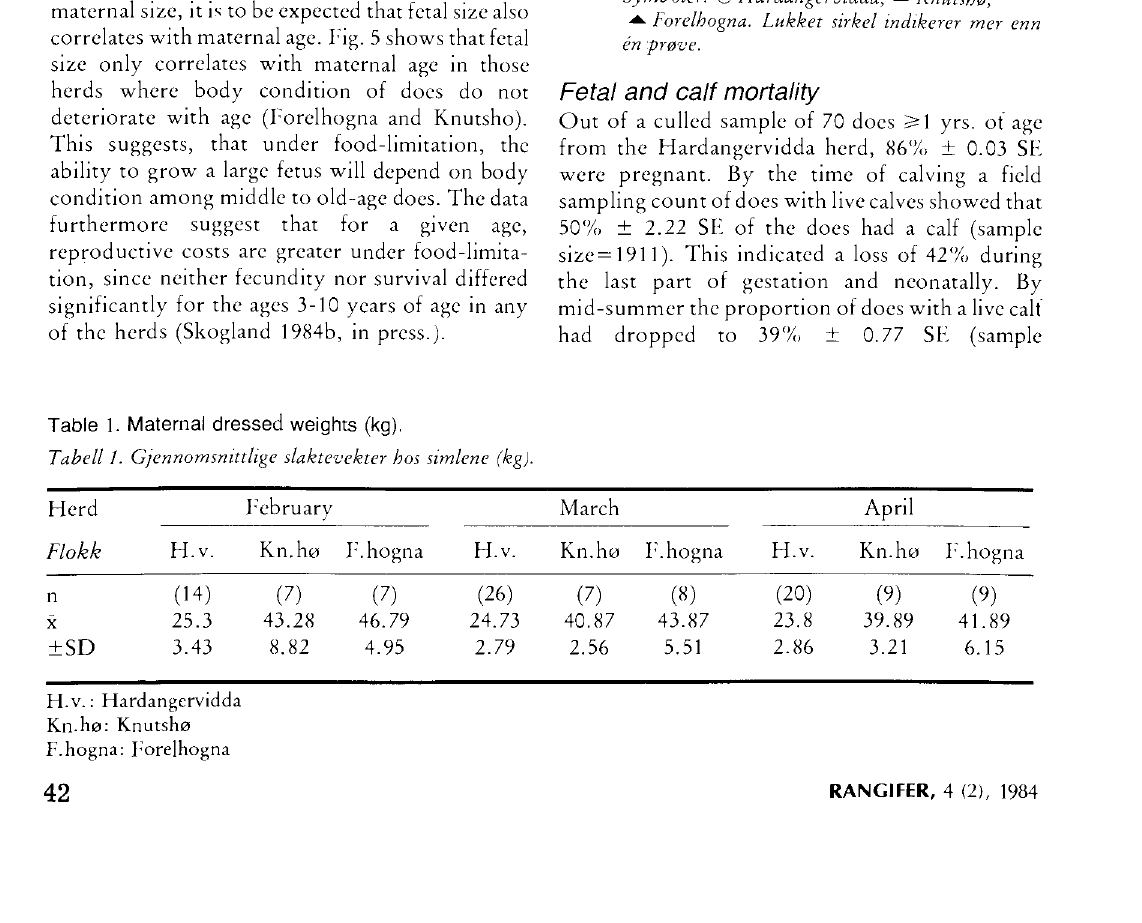
Fig. 3. The relationship between fetal weight and maternal dressed weights in April. Legends: O Hardangervidda, Knutshø, Forelhogna. Closed sircle indicates more than one plot. Fig. 3. Forholdet mellom fostervekt og simlenes slakte vekter i april. Symboler: O Hardangervidda, Knutshø, Forelhogna. Lukket sirkel indikerer mer enn én prøve. Fetal and calf mortality Out of a culled sample of 70 does >1 yrs. ot age from the Hardangervidda herd, 86% ± 0.03 SE were pregnant. By the time of calving a field sampling count of does with live calves showed that 50% ± 2.22 SE of the does had a calf (sample size = 191 1). This indicated a loss of 42% during the last part of gestation and neonatally. By mid-summer the proportion of does with a live calt had dropped to 39% ± 0.77 SE (sample